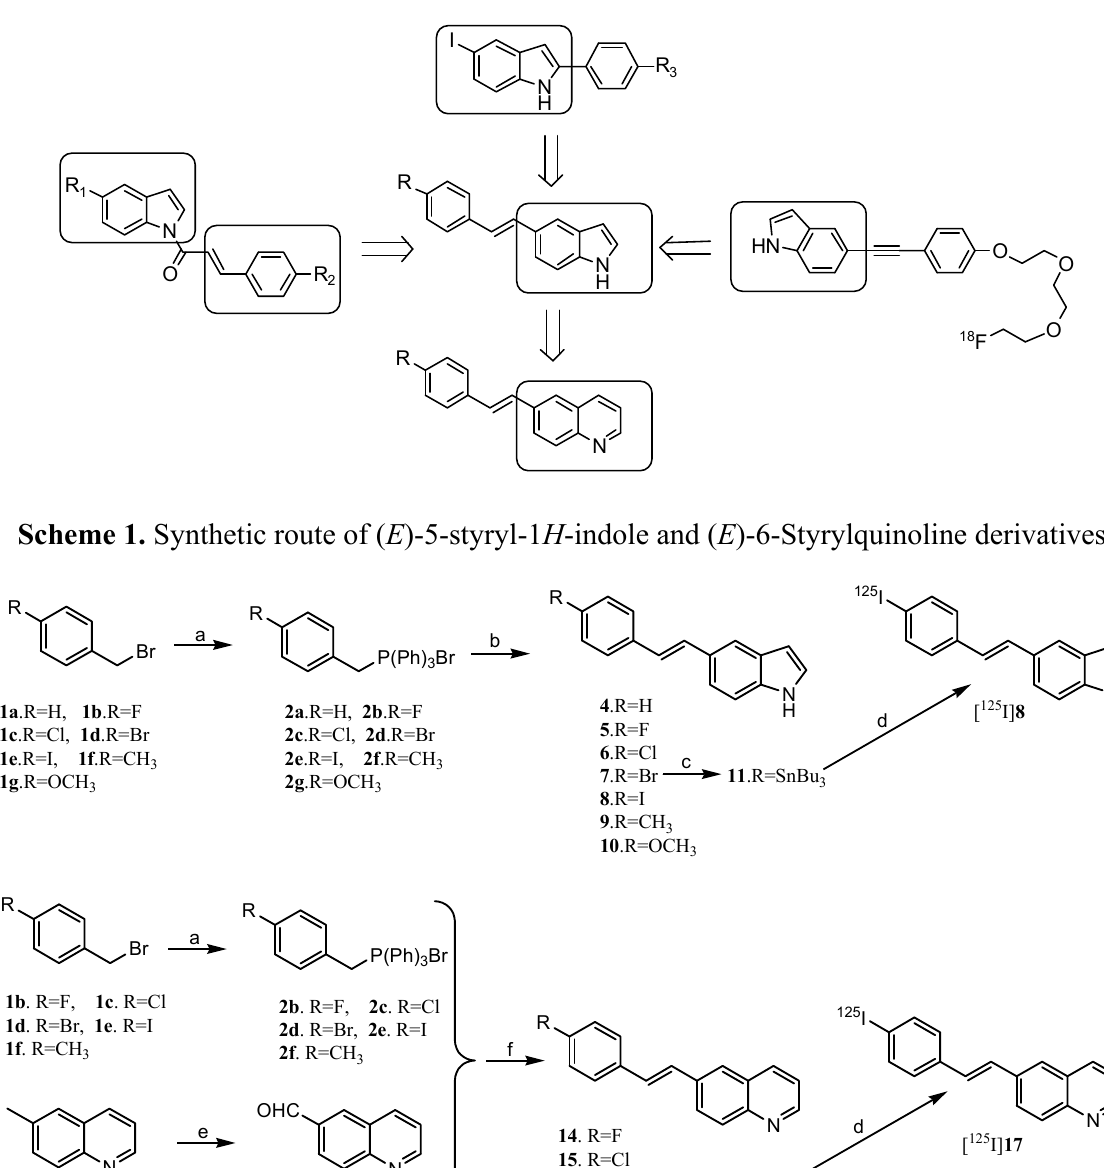
Figure 2. Design considerations of ( E )-5-styryl-1 H -indole and ( E )-6-styrylquinoline derivatives.